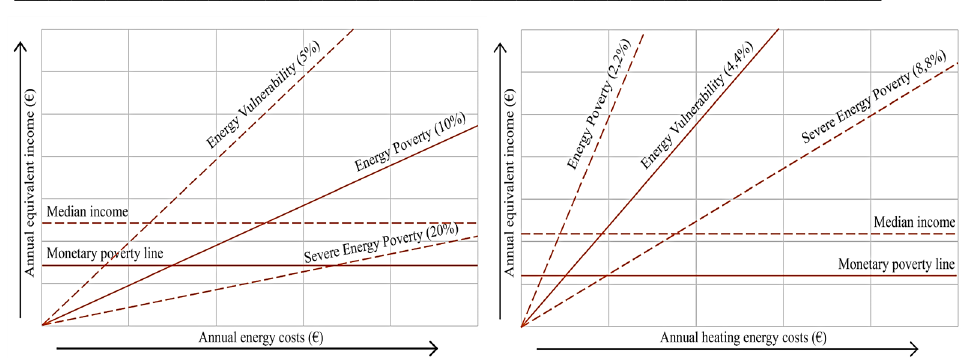
Fig. 1. Energy poverty assessment for total energy expenditure (left), and Energy poverty assessment for the Mediterranean climate (right)